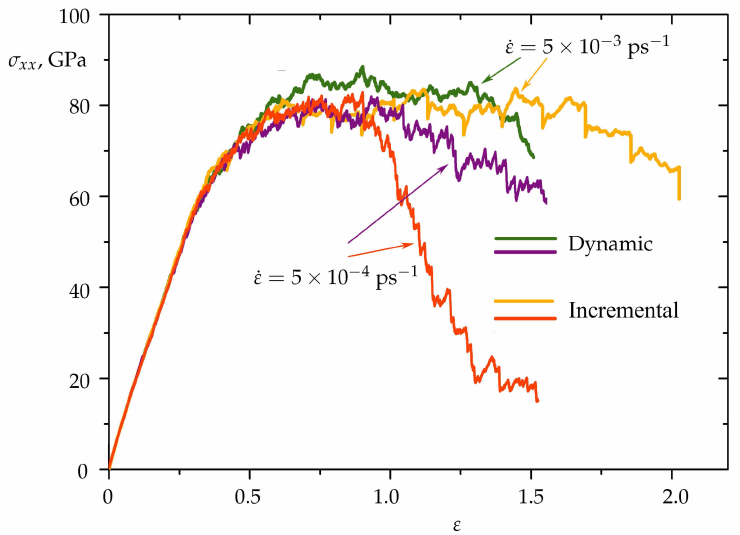
Figure 8. Stress–strain curves during uniaxial dynamic (green and violet curves) and incremental (orange and red curves) tension along x -axis for strain rate ˙ ε = 5 × 10 − 3 ps − 1 and ˙ ε = 5 × 10 − 4 ps − 1 at 0 K.